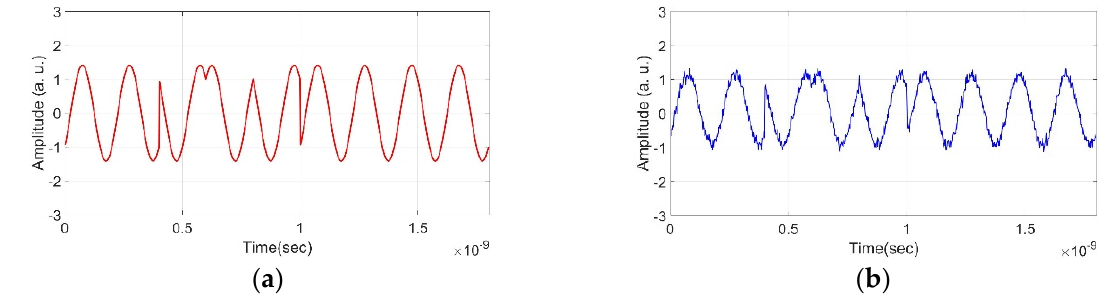
Figure 7. ( a ) Transmitted QPSK signal. ( b ) Recovered QPSK signal. Figure 8a,b show the constellation diagrams corresponding to the transmitted and received signal, respectively.